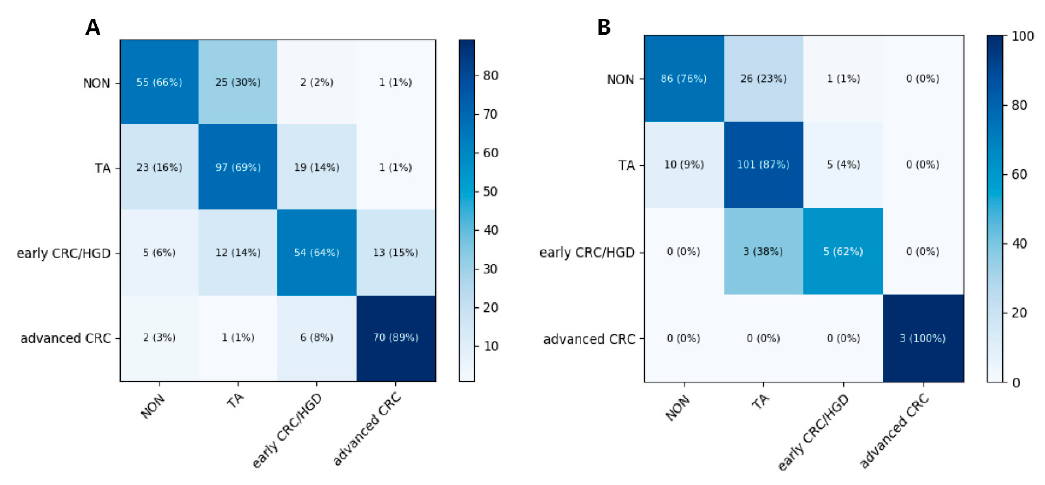
Figure 3. Heat maps of the ResNet-152 confusion matrices for four-category classification scheme for colorectal lesions on colonoscopic photographs ( A ) in the test dataset and ( B ) in the external validation dataset. NON, non-neoplastic lesion; TA, tubular adenoma; HGD, high-grade dysplasia; CRC, colorectal cancer.